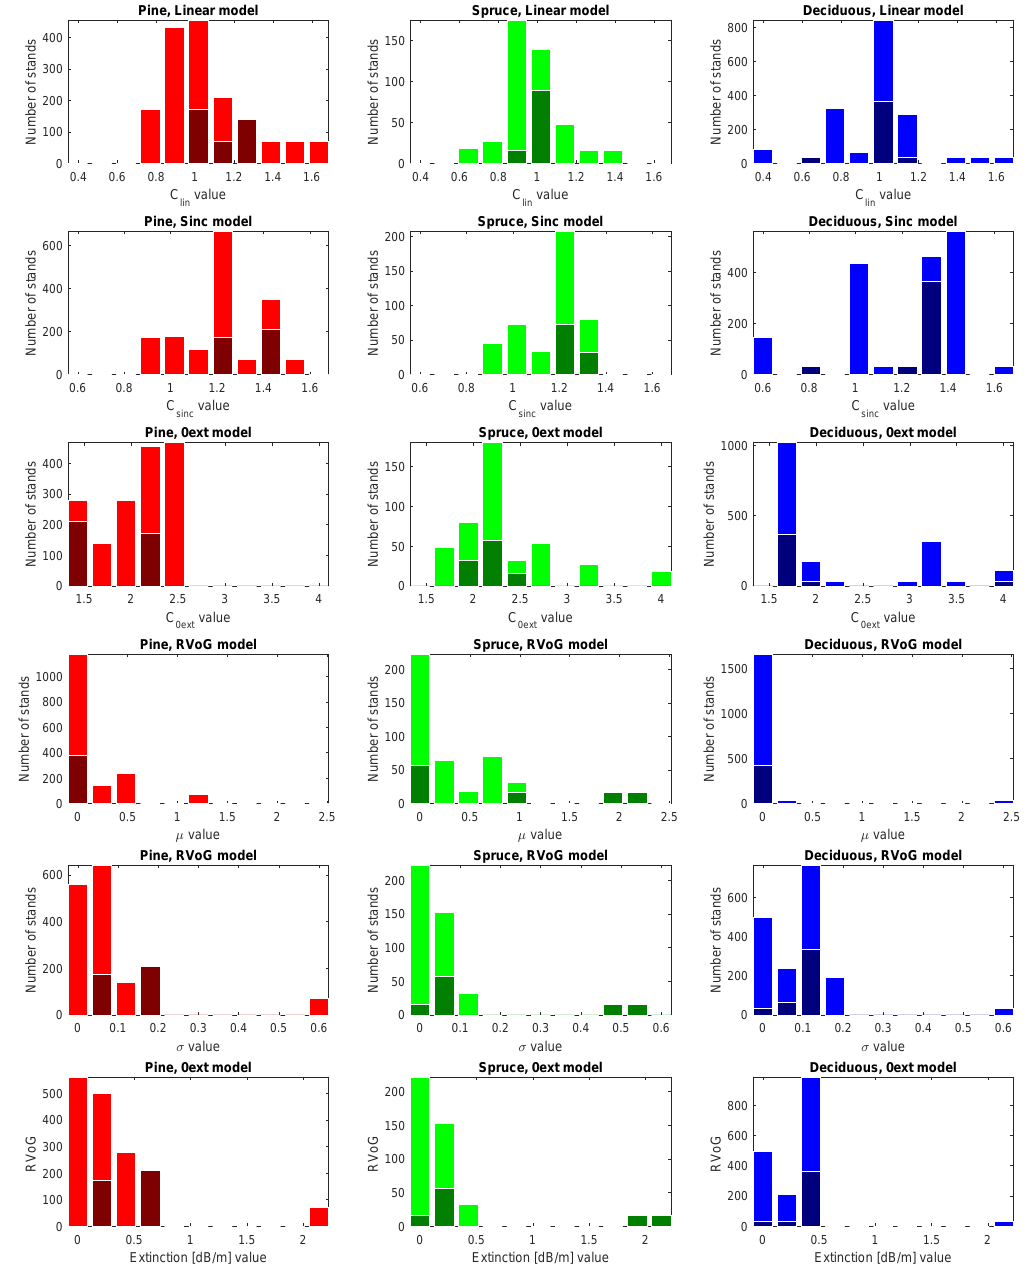
Figure 8. Parameters fitted for the chosen models. The darker bars depict histograms for a subset of scenes: 4 January 2011, 3 March 2012, 8 March 2012, 14 March 2012 and 25 March 2012. For these scenes, HoA was approximately twice as large as the highest stand